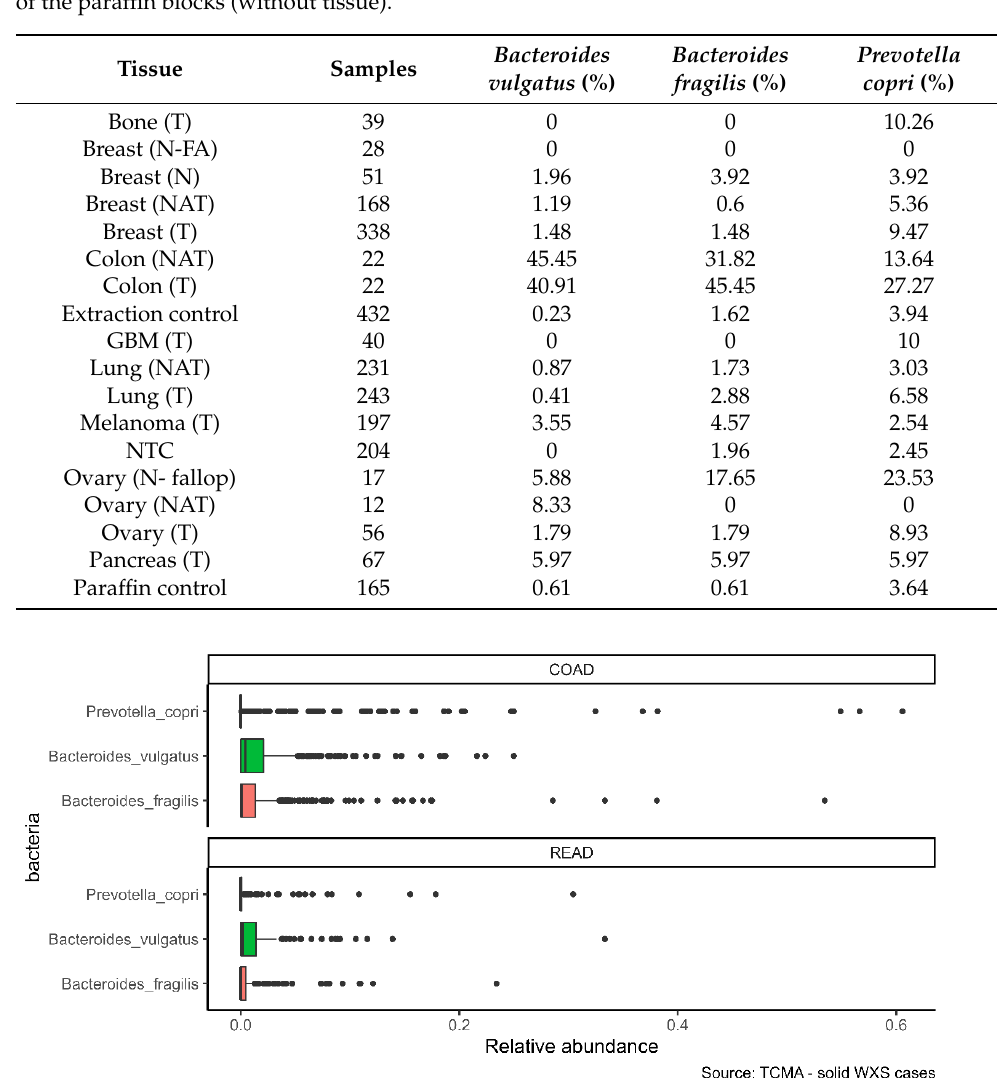
Tumor (T), normal adjacent tissues (NAT), normal fibroadenoma (N-FA), and negative controls from [22] were included in the analysis. The % of the positive samples, defined as samples that have more than zero normalized reads of the bacterium, is reported. Contaminants included negative controls that were processed with the samples, including 432 DNA extraction controls and 204 pol- ymerase chain reaction (PCR) no-template controls (NTCs), and 165 paraffin-only samples taken from the margins of the paraffin blocks (without tissue).